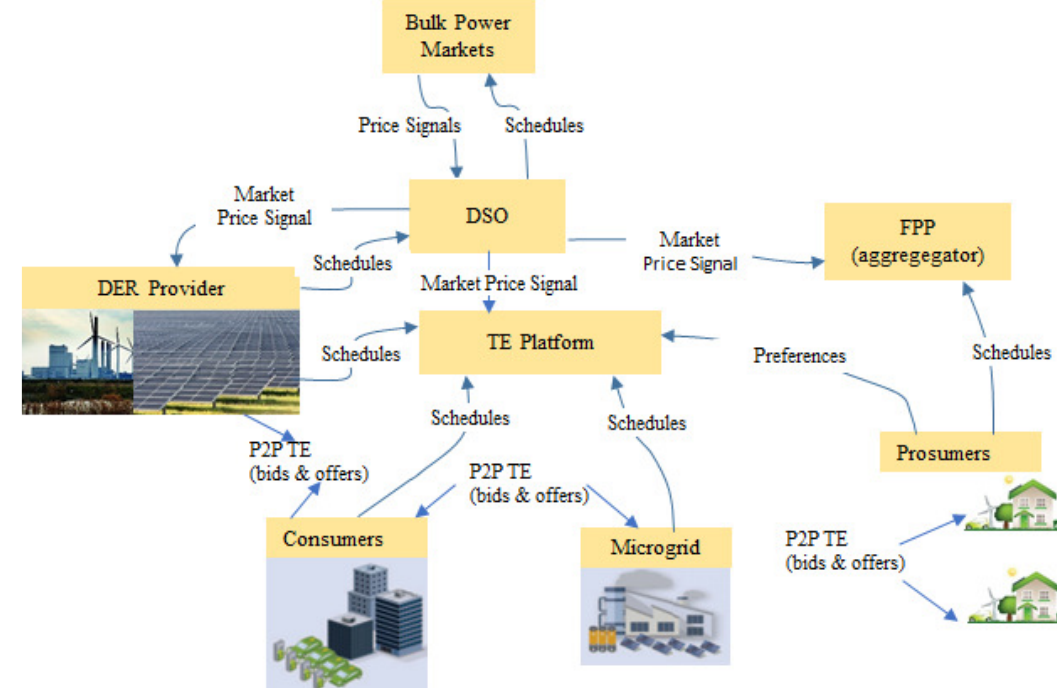
Figure 5. Actors’ interaction with the energy trading platform [105]. FPP: federated power